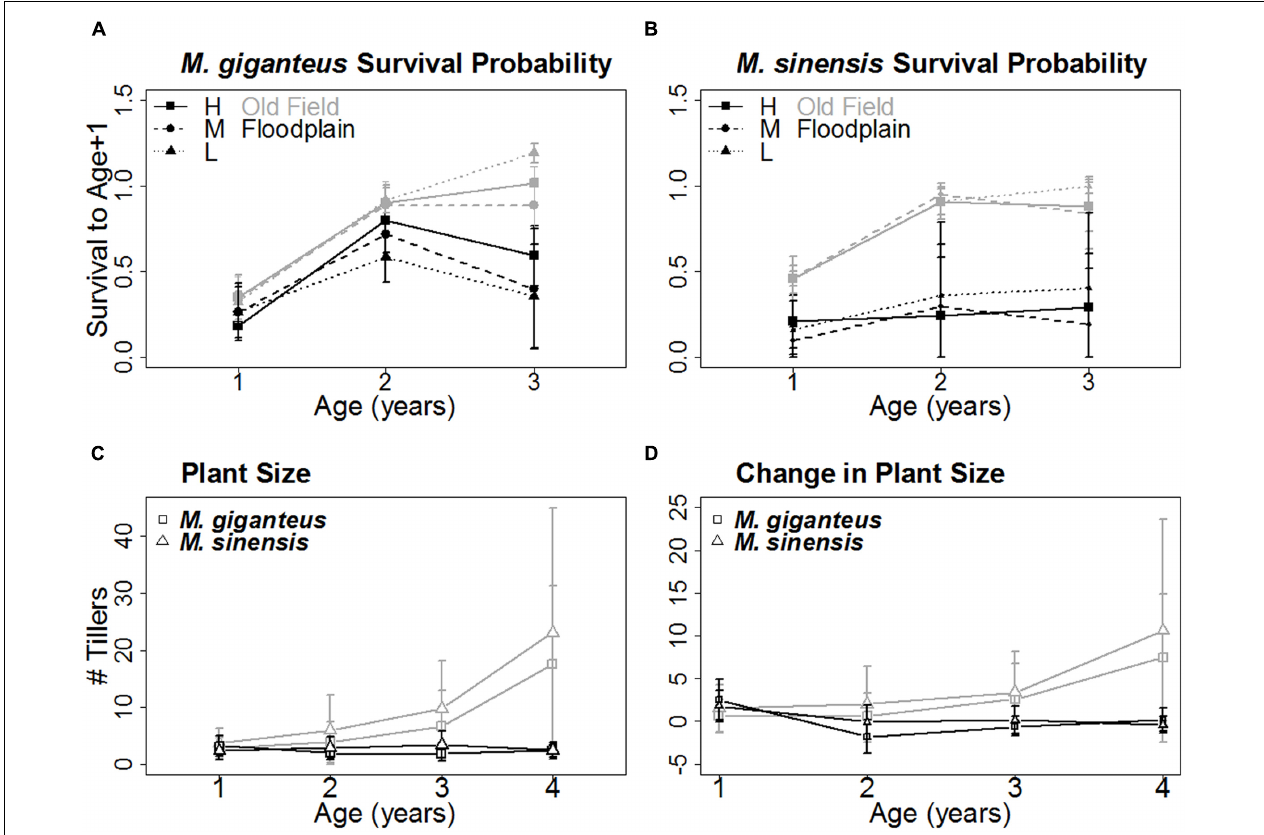
FIGURE 3 | Age-related survival and growth of each species (Mean ± SD). The probability of surviving to the next year increased similarly with age for both M. giganteus (A) and M. sinensis (B) in old field (gray) but not floodplain (black) habitats. Size, represented by tiller number (C) and growth, represented by change in tiller number (D) , with age followed a similar pattern. Both increased with age in old field but not floodplains for both M. giganteus (squares) and M. sinensis (triangles). The x -axis for (A) and (B) represents the three yearly age transitions. The x -axis for (C) and (D) represents years of age. TABLE 2 | Richness (A, # of species) and Evenness (B, J ) for control (no Miscanthus ) and Treatment ( M. giganteus or M. sinensis addition) plots in each of the three old field sites. Site (A) Richness (B) Evenness